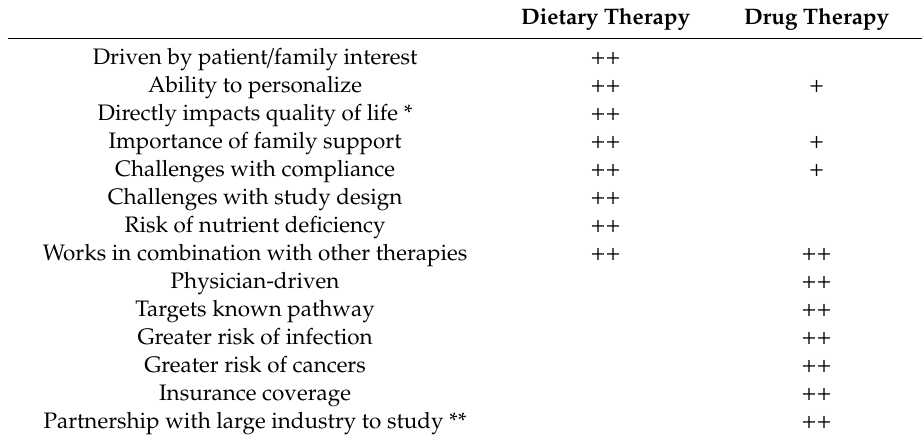
Table 2. Comparison of Dietary Therapy and Drug Therapy. Dietary